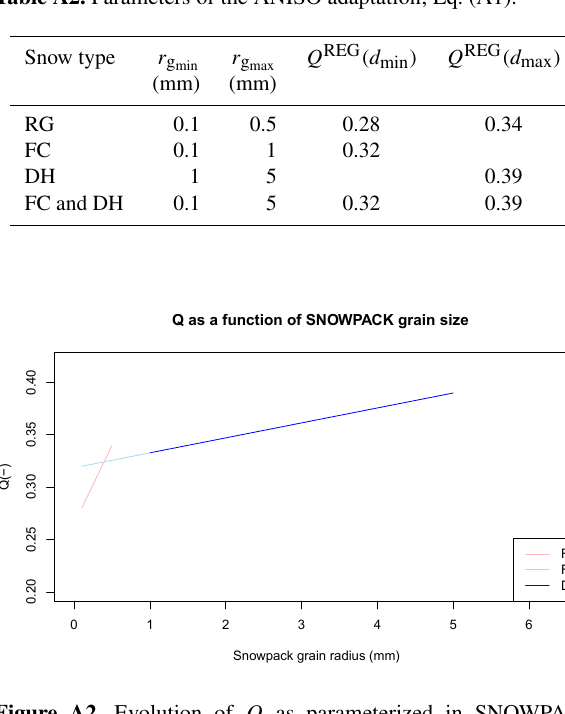
Figure A2. Evolution of Q as parameterized in SNOWPACK ANISO